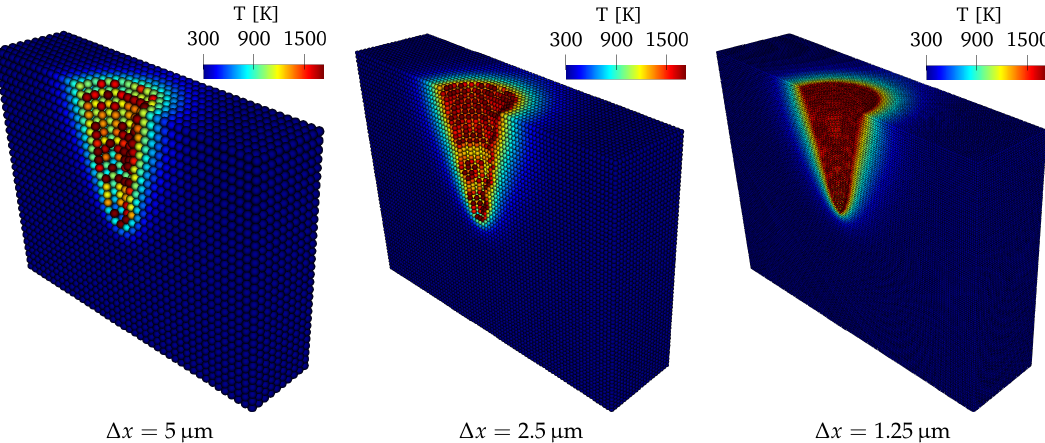
Figure 10. Impact of the discretization size. Only half of the domain is shown for better visualization.